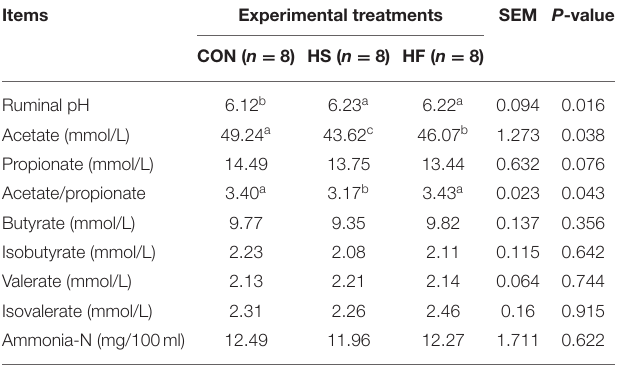
TABLE 3 | Effects of honeycomb flavonoids supplement on rumen fermentable parameters during heat stress conditions.